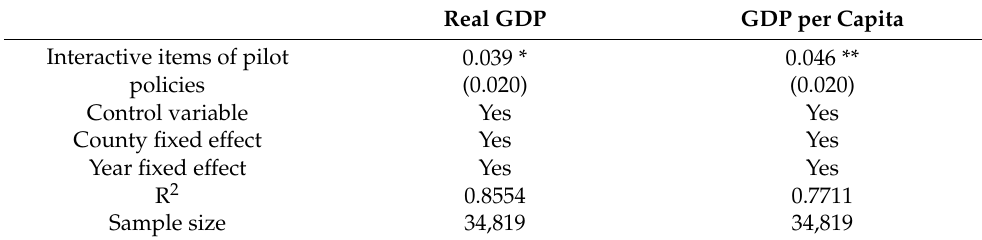
Table 4. PSM-DID stability test results.